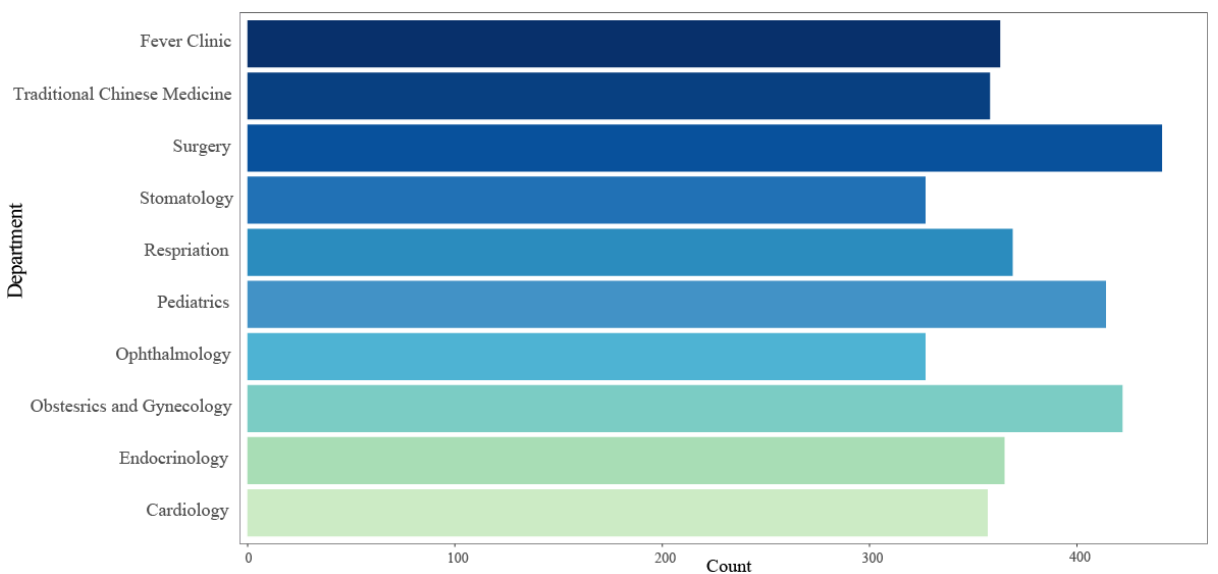
Figure 7. A bar plot that depicts the number of available departments in internet